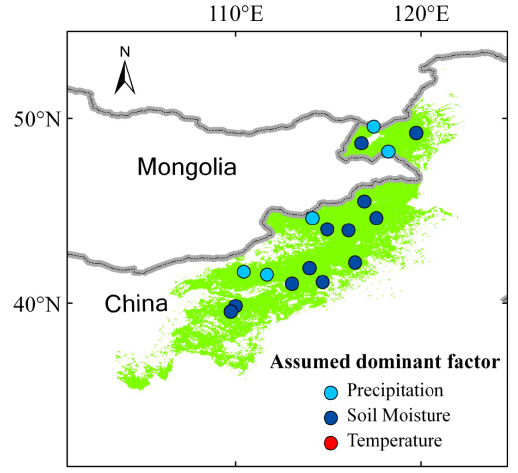
Fig. 12. The spatial pattern of assumed dominant factor based on which could get the best regression of Green-up Onset Date in Inner Mongolia. 3